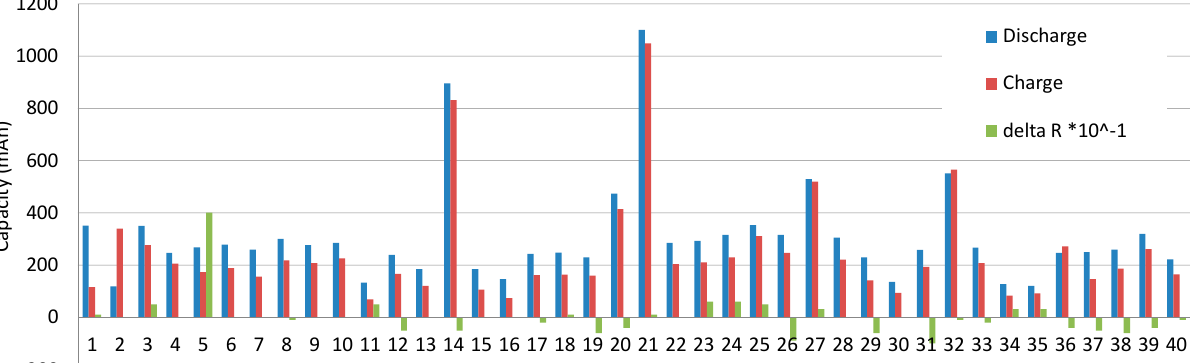
Figure 20. Comparison of cells capacities determined with the charging and discharging method.